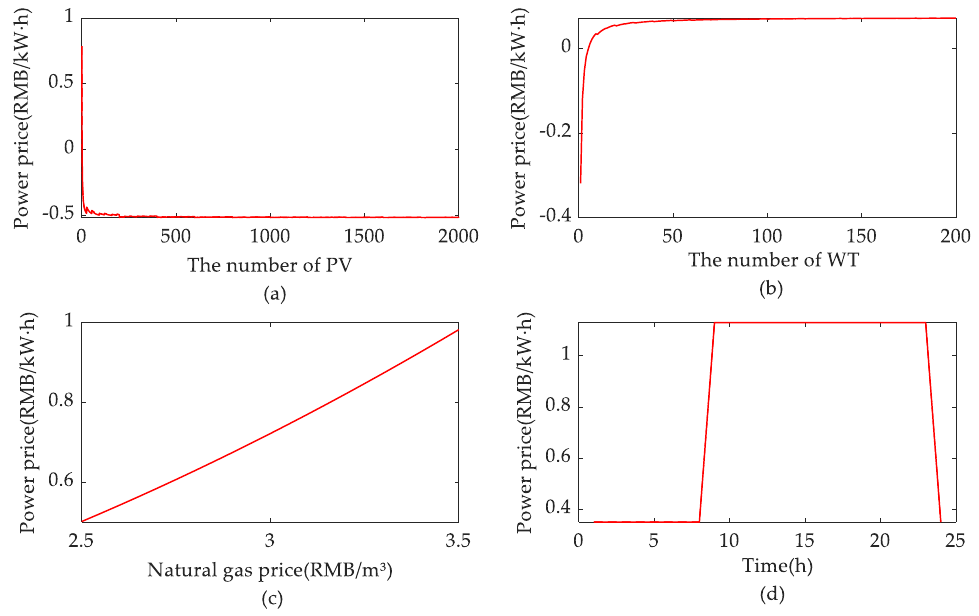
Figure 2. Power cost laws based on different methods. ( a ) The energy cost changing with the number of photovoltaics (PVs); ( b ) The energy cost changing with the number of wind turbines (WTs); ( c ) The power cost generated by gas turbines (GTs) changing with the natural gas price; ( d ) The power price at Yantai changing with different points in time.